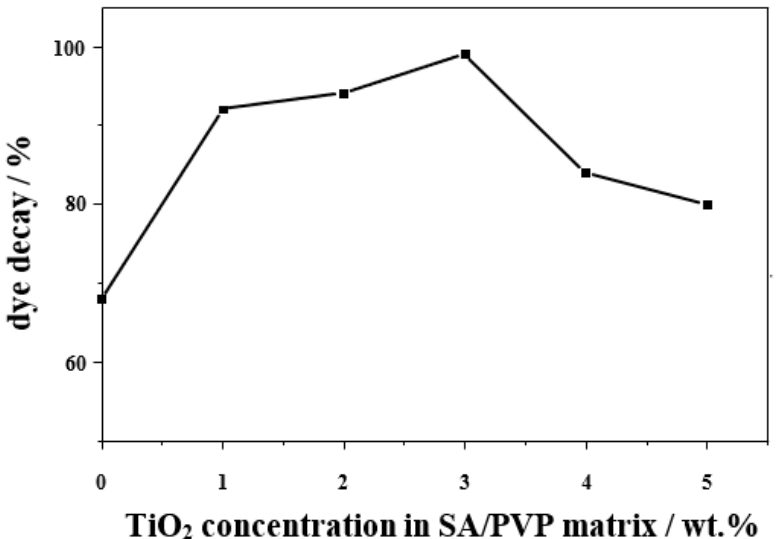
Figure 4. The influence of catalyst loading on dye degradation (pH 7; illumination time: 120 min; initial MB concentration: 50 mg L − 1 ; and light intensity: 1200 lm). Table 1. Experimental data * on the effect of illumination time on MB dye degradation (%) using SA/PVP/TiO 2 nanocomposite